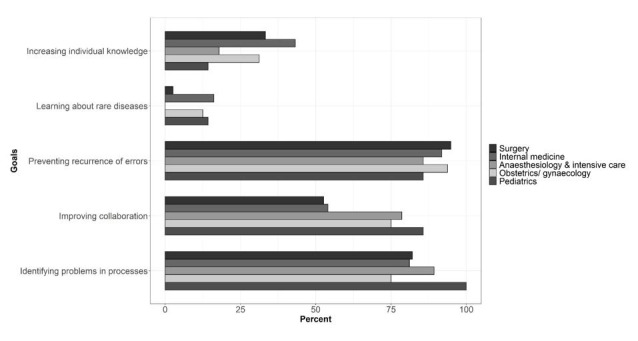
Goals presented separately for each medical discipline.